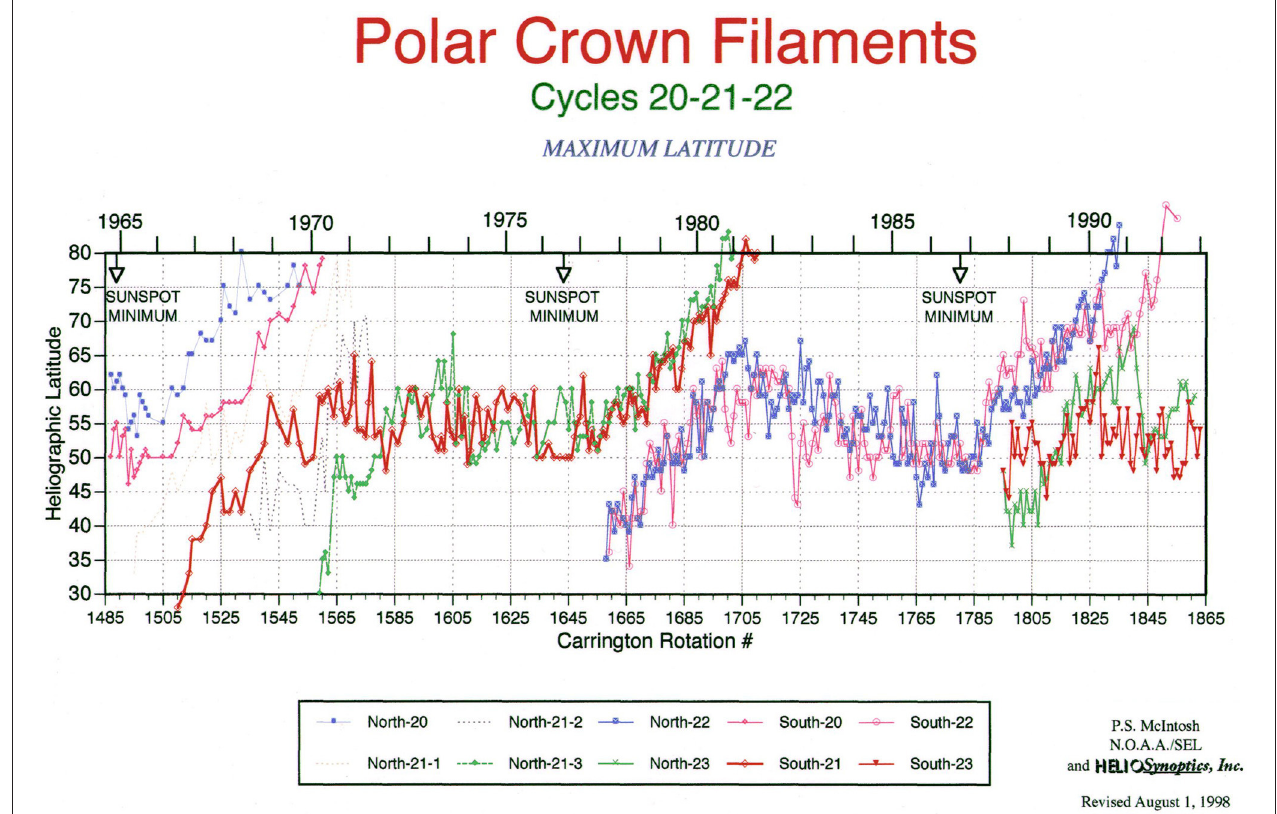
FIGURE 2 | Maximum, poleward-most latitudes of filaments in the primary and secondary PCFs for both hemispheres for cycles 20–22. Both hemispheres have been folded together. P. McIntosh produced this figure in 1998; also see Figure 4 in Webb (1998) and Figure 5 in McIntosh (2003).